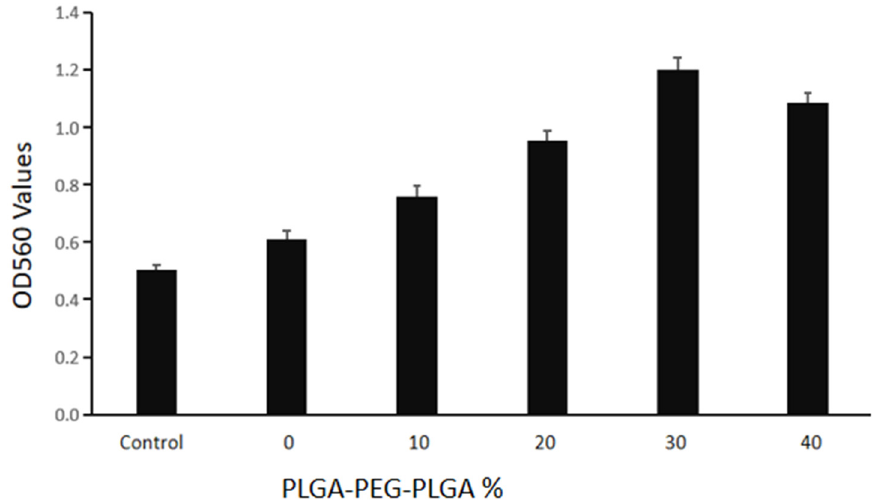
Figure 12. Quantitative results of alizarin red staining for each group.